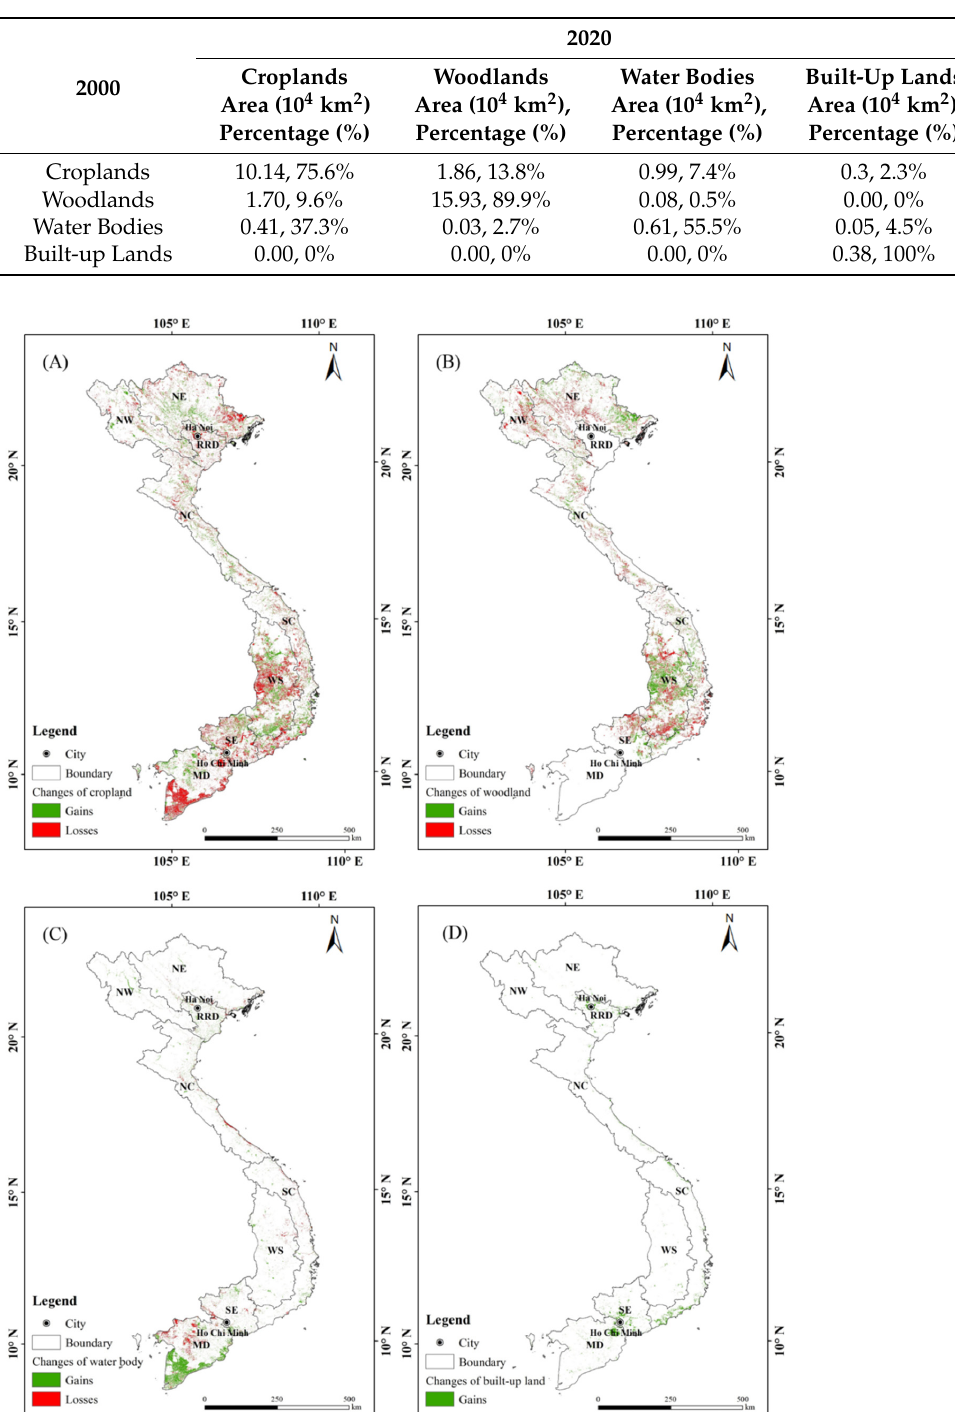
Table 5. Land-use/land cover transfer matrix in Vietnam during the period 2000–2020.